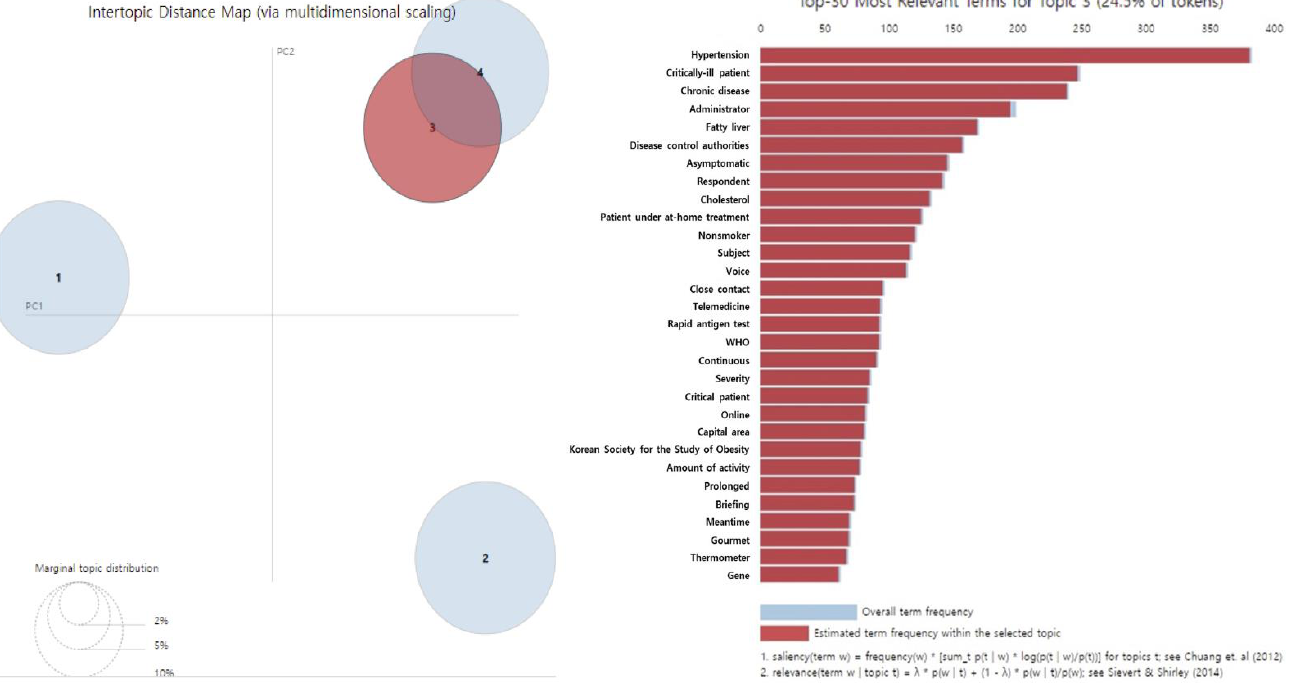
Figure 3. Results of LDA topic modeling ‘Topic 3’ in people with diabetes during the COVID -19.